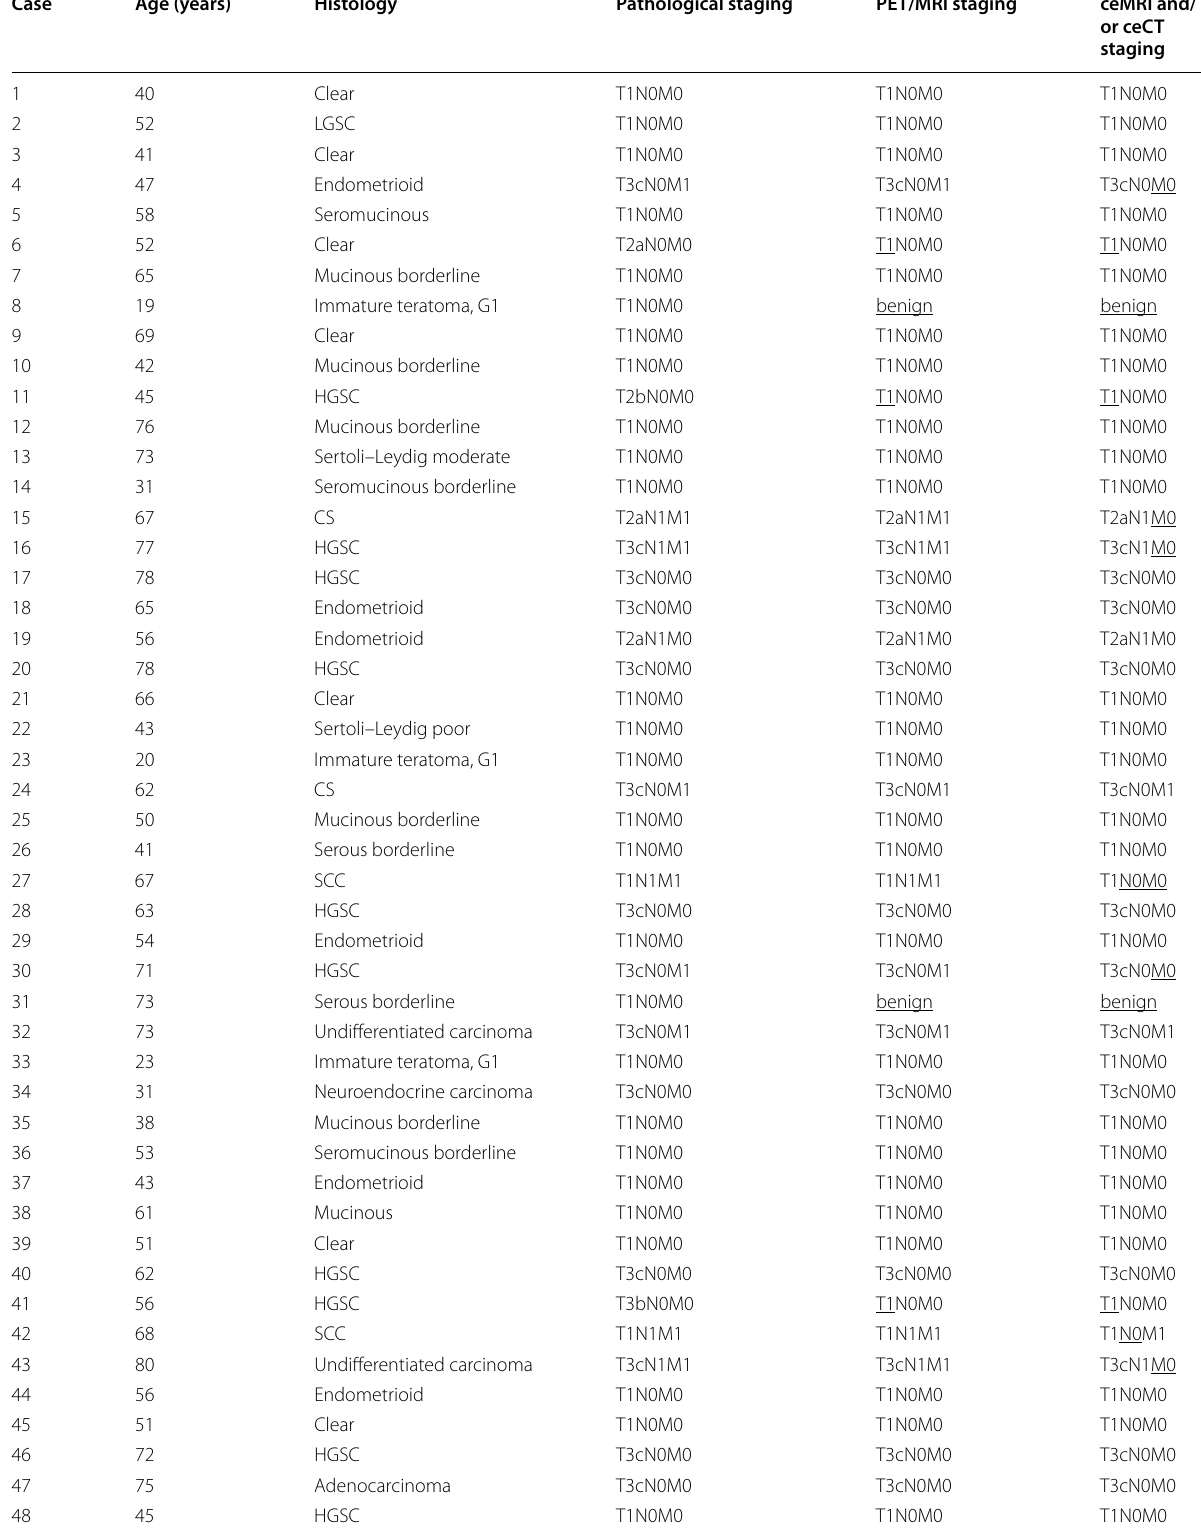
Table 1 Characteristics of patients with primary ovarian